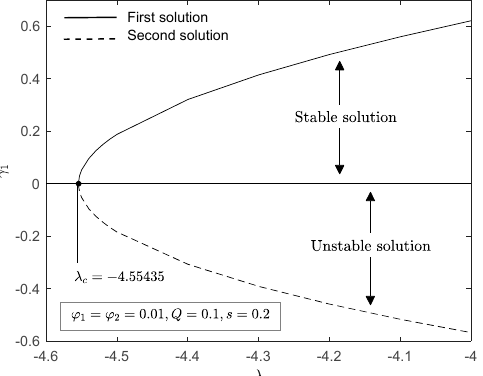
γ against λ . Figure 14. Smallest eigenvalues γ Figure 14. Smallest eigenvalues 1 against λ . 1 Nu x Re − 1/2 (local Nusselt number) with λ (mixed convection parameter) in the x